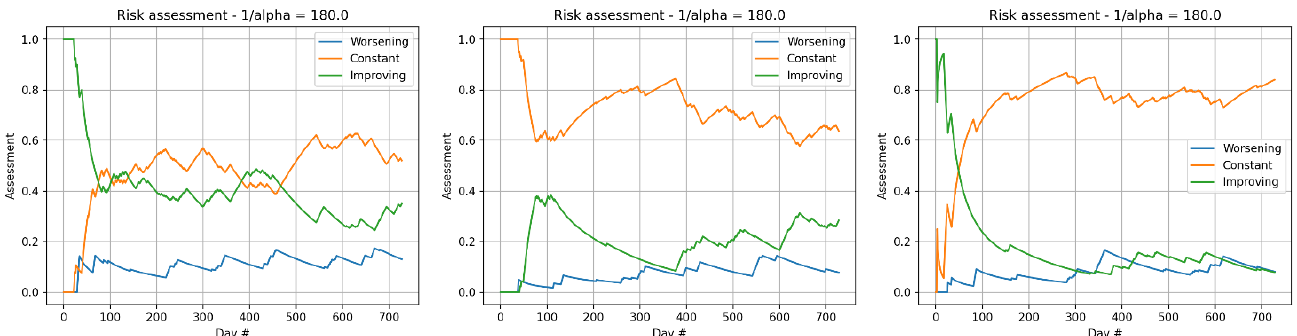
Figure 8. Averaged outputs of the tri-state random forest classifier with 2048 trees for the first athletic person ( left ) with a risk grade after two years of 46.2, for the first balanced person ( middle ) with a risk grade of 15.2, and the first gamer ( right ) with a risk grade of 2.9.